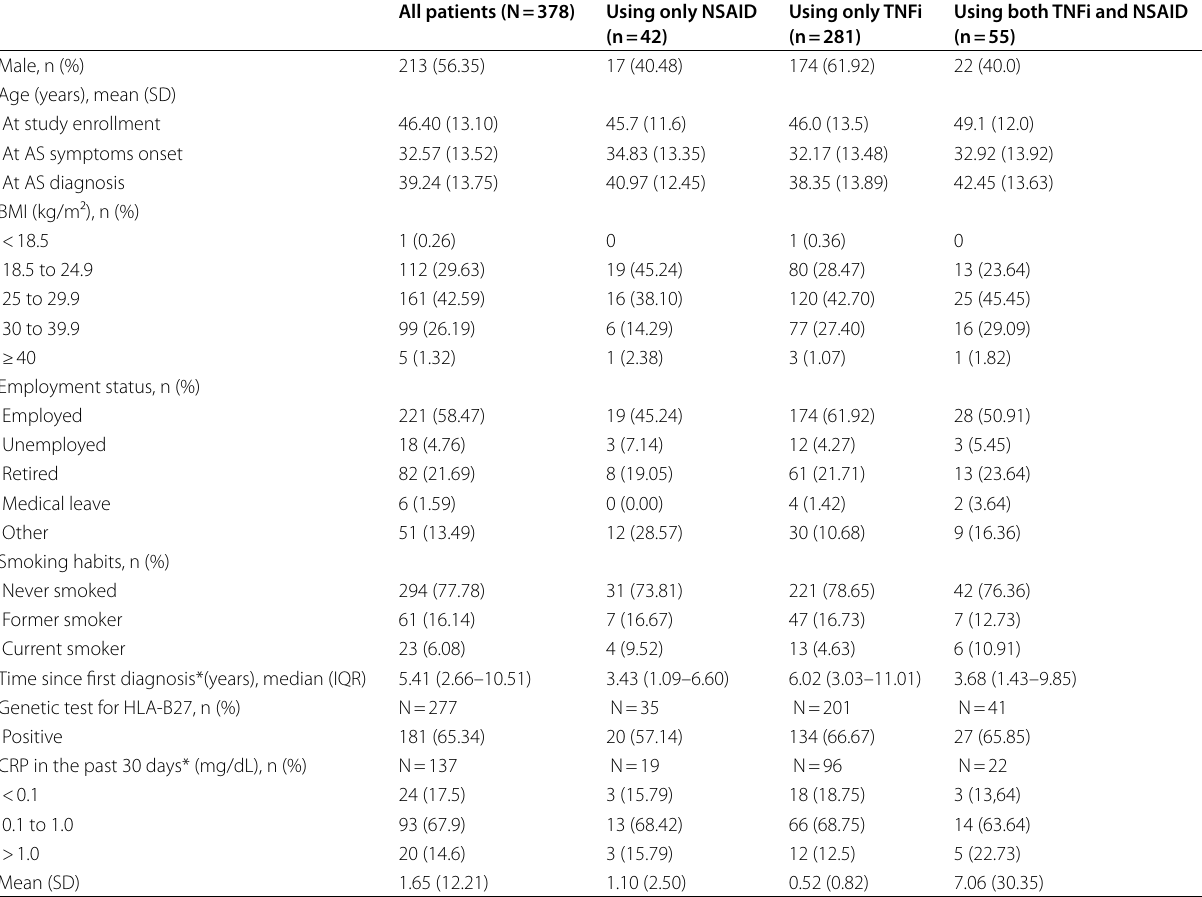
Table 1 Clinical and demographic characteristic of patients enrolled in INVISIBLE-BRAZIL study